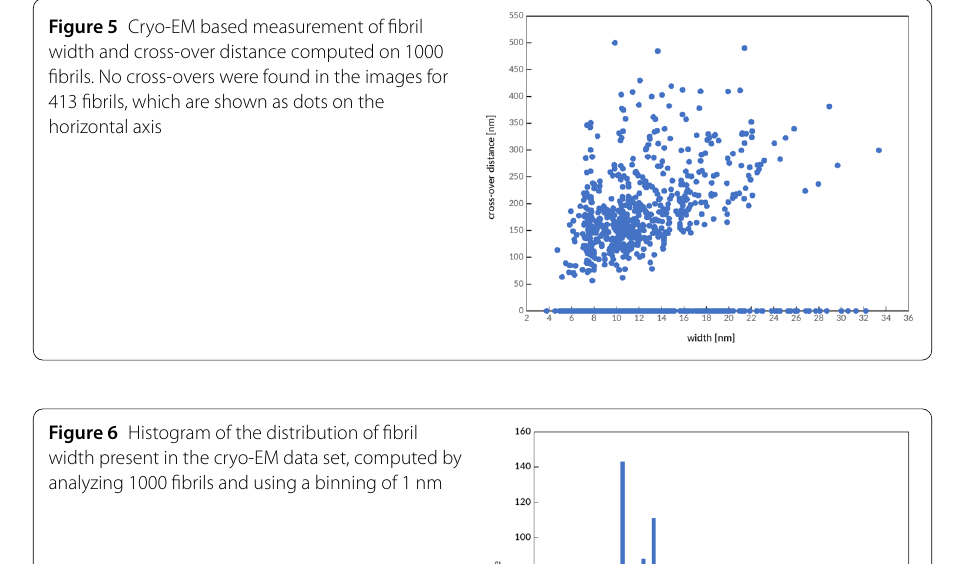
Figure 5 Cryo-EM based measurement of fibril width and cross-over distance computed on 1000 fibrils. No cross-overs were found in the images for 413 fibrils, which are shown as dots on the horizontal axis